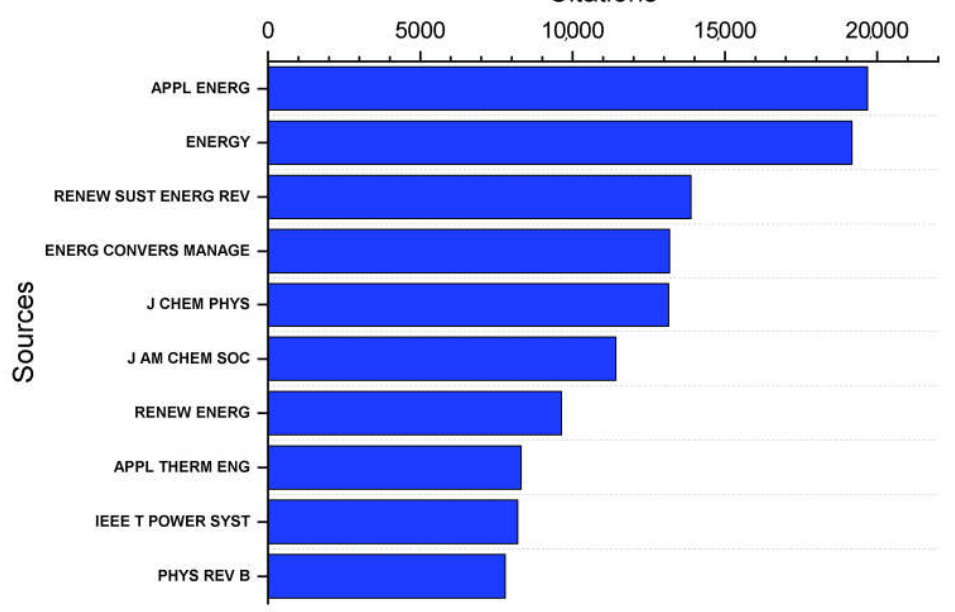
Figure 6. Source citations.